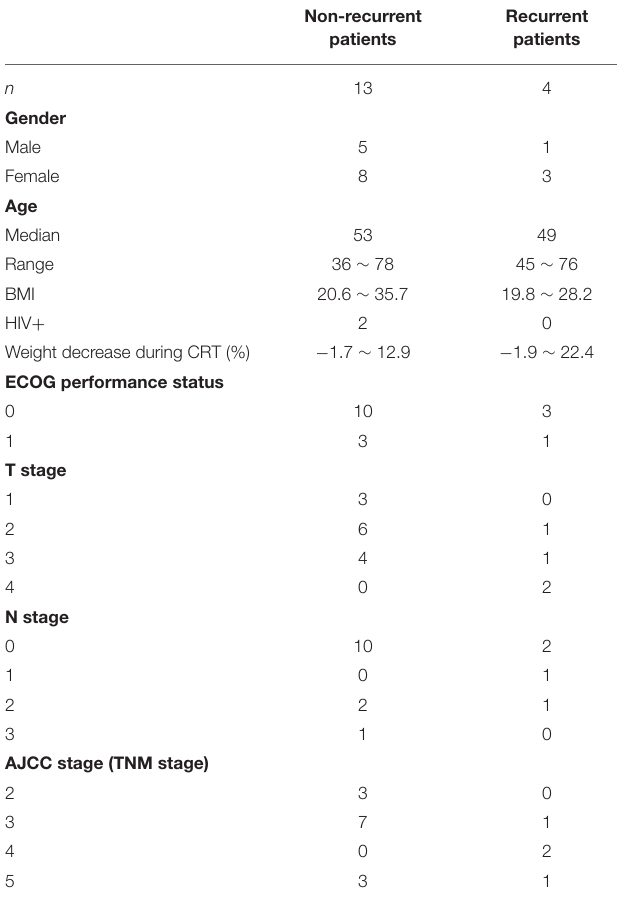
TABLE 1 | Clinical characteristics of